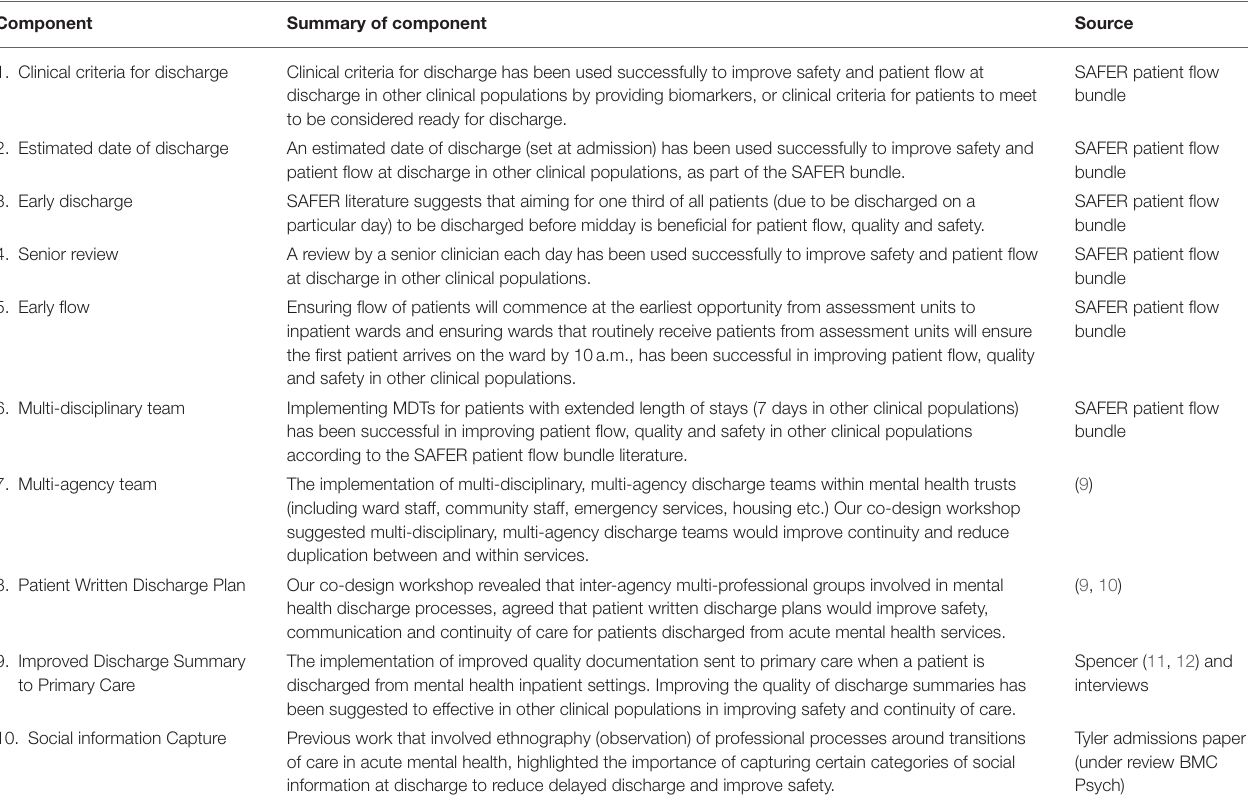
TABLE 1 | Evidence sources informing potential intervention components (created by